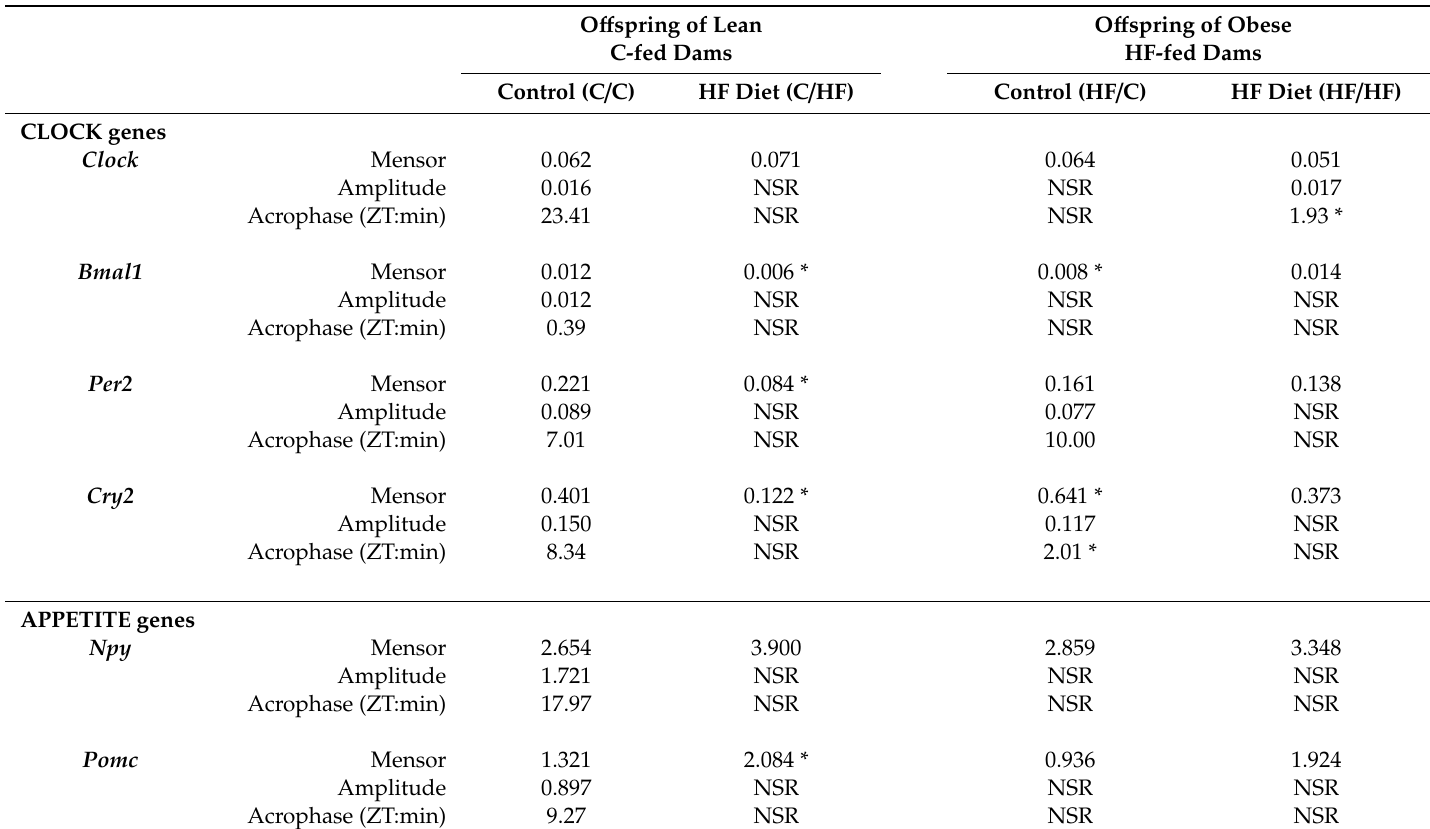
Table 2. Analysis of circadian clock gene and appetite gene expression in the o ff spring Suprachiasmatic Nucleus (SCN) and Arcuate Nucleus (ARC), respectively.